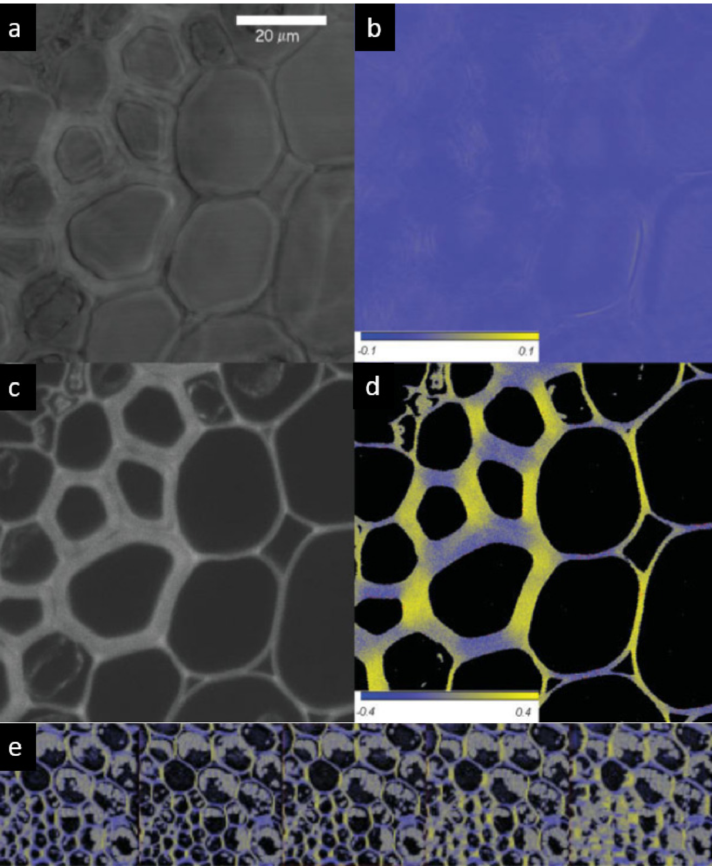
Figure 6. Non-confocal transmission ( a ) and orientation factor (S = LD/3A) ( b ) images, and confocal fluorescence intensity ( c ) and FDLD ( d ) images of thin sections of the root of Convallaria majalis stained with acridin orange. False colours and scales in ( b , d ) indicate the sign and magnitude of the dichroism. ( e ) Gallery of 3D reconstructed FDLD images. Bar is 20 µ m. (Composed from figures published in [49], with permission from John Wiley and